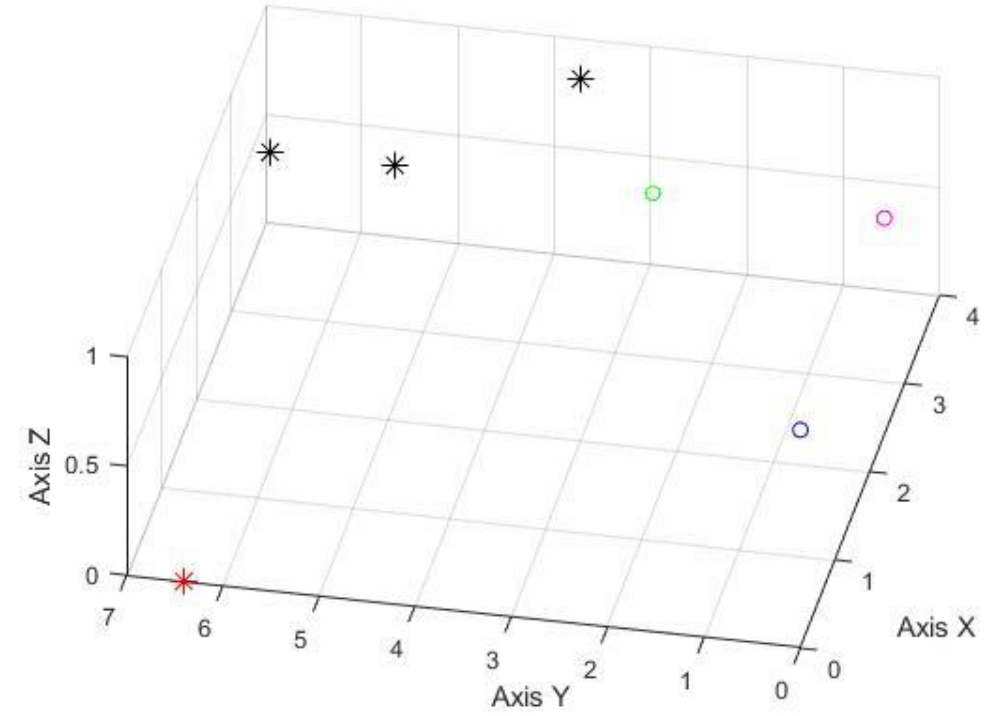
Figure 8. The experimental results of no shielded signal (unit in meter); the red asterisk represents the signal origin; the black asterisks are the estimated positions from three on-site testing. The red, blue, and green circles are the locations of three BLE signal observation points.